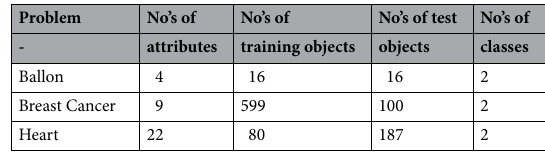
Table 13. Classification databases 14 .